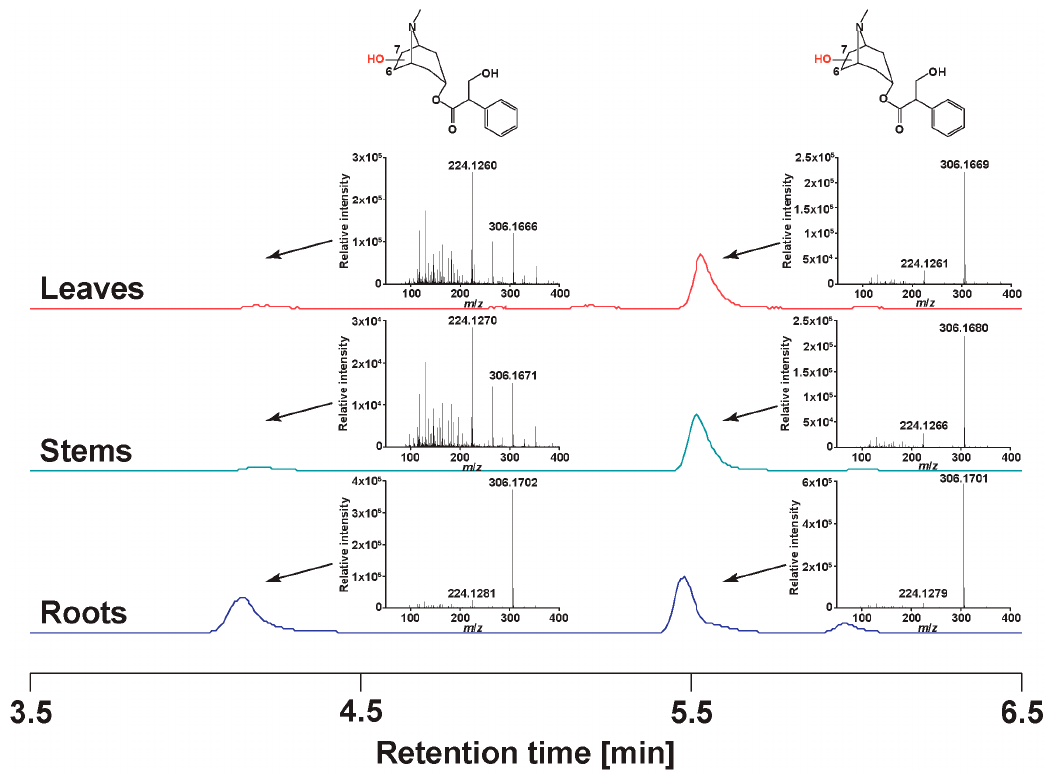
Figure 5. The relative concentration of putative anisodamine isoforms in Datura stramonium .